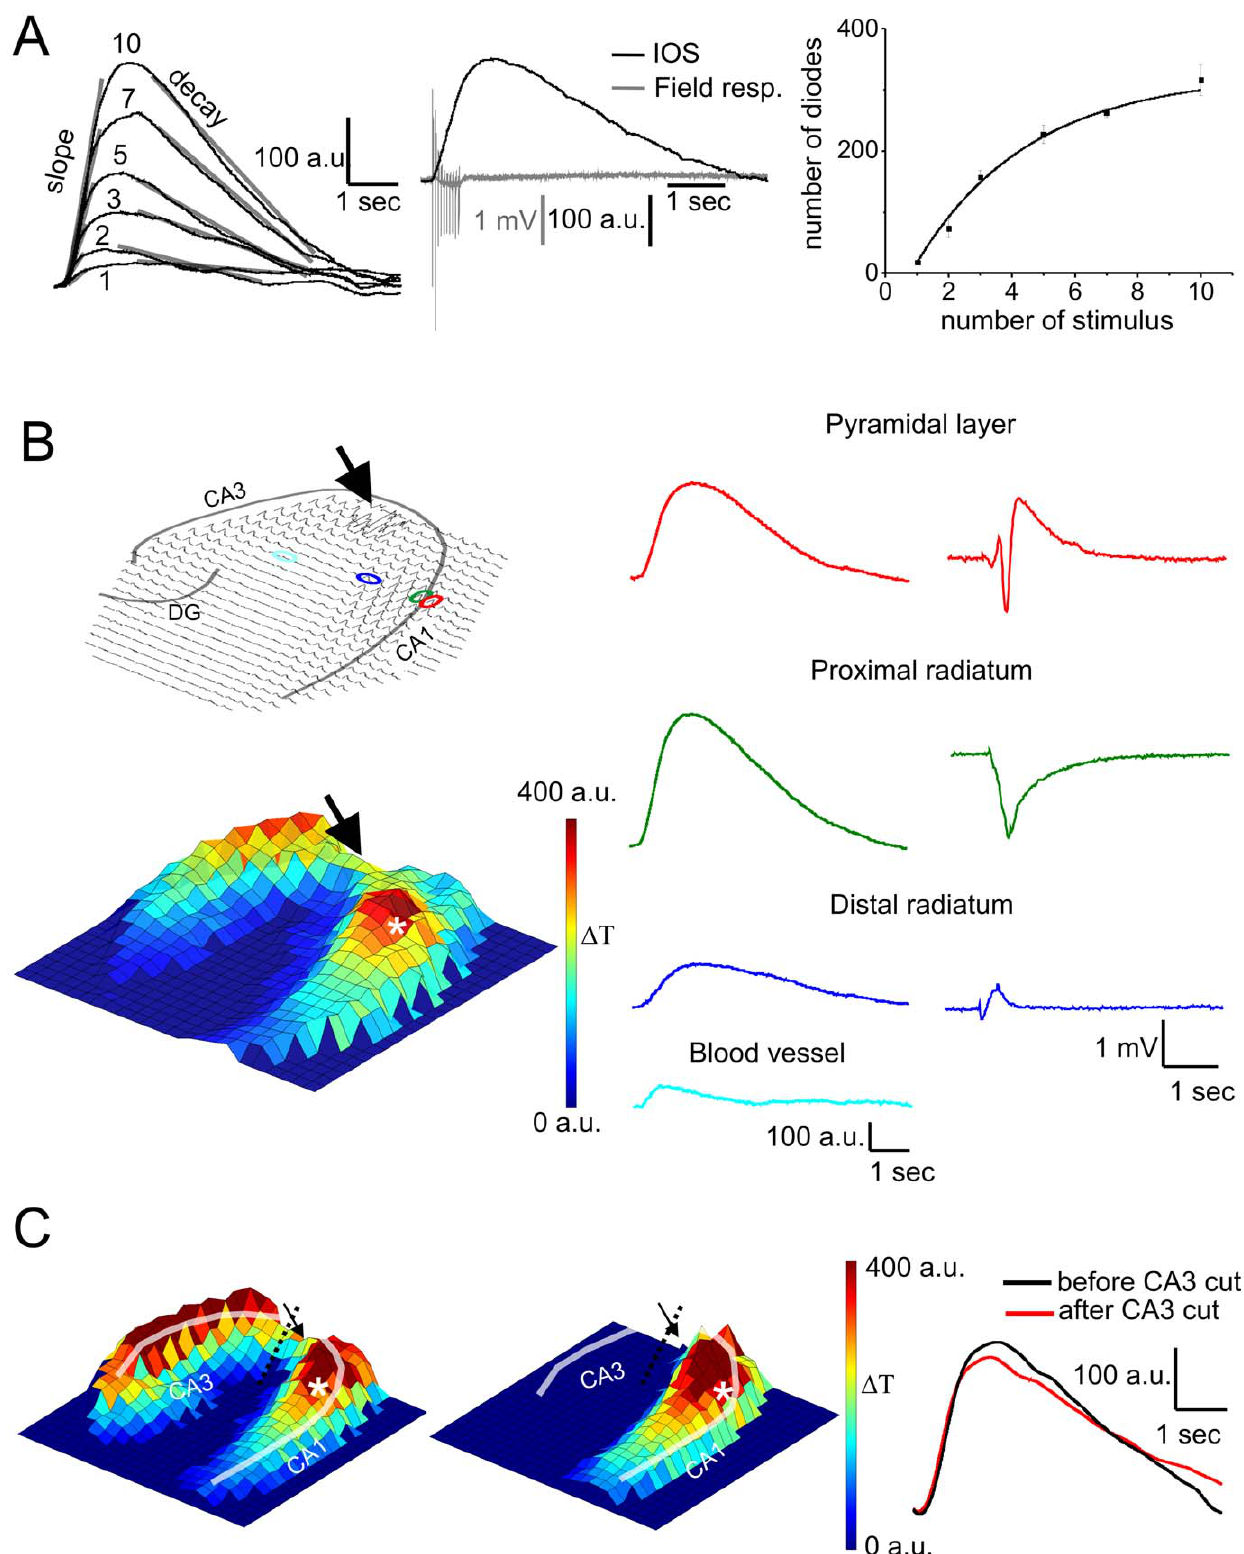
Figure 1. Time course, stimulation dependency and regional distribution of IOS and field response. A left: Changes of IOS shape and amplitude with the increasing number of stimuli. Numbers above that curves indicate the stimulus number. Transparent lines show the fitted linear function to calculate the slope and decay of the IOS curves. A middle: Time course of the IOS and field response A right: Correlation between the number of diodes containing IOS and the stimulus number (R 2 =0.99). B Top left: Overview of the IOS signal on the 464 element photodiode array.